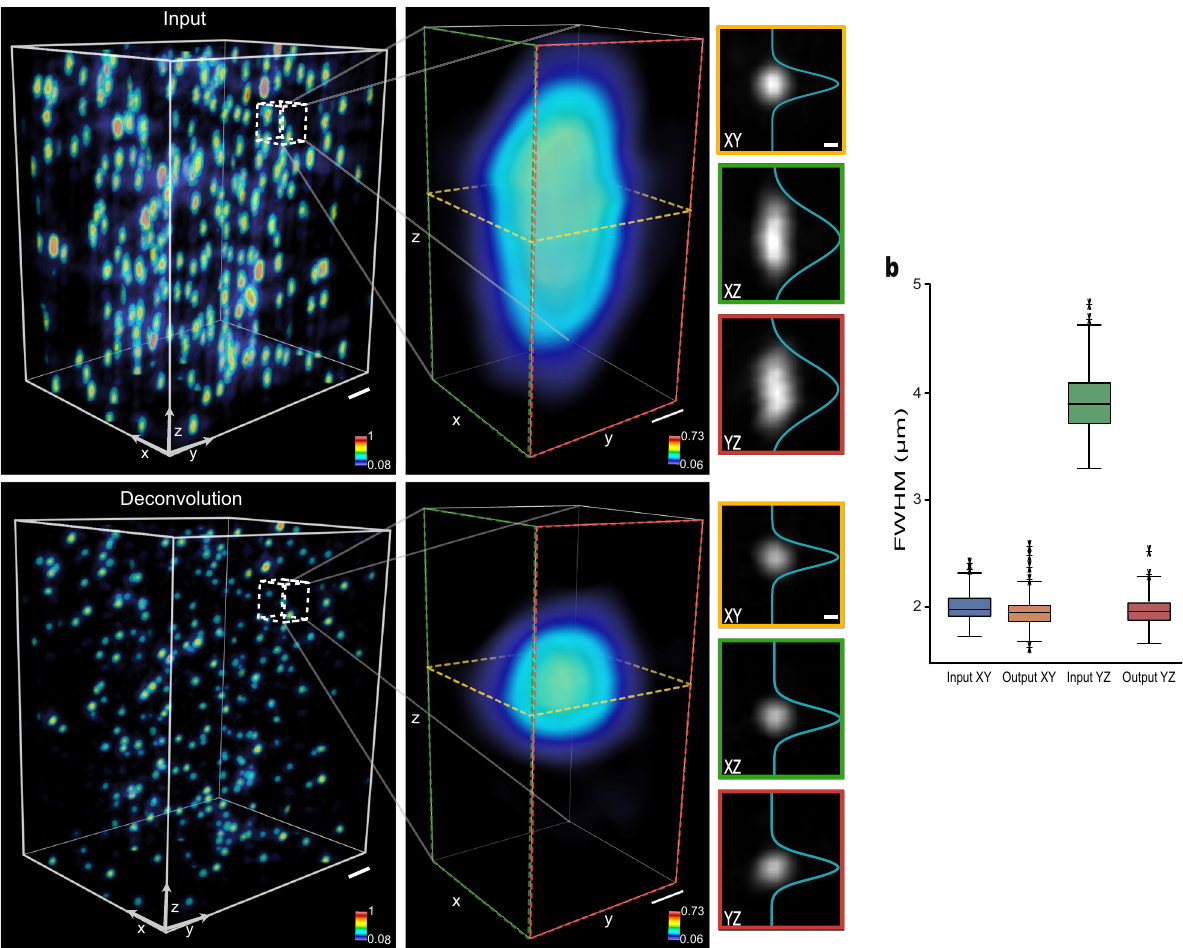
Fig. 3 PSF Deconvolution by the framework. The 0.5- µ m fl uorescent beads were imaged to model the PSF of the OT-LSM system experimentally. a An example of PSF deconvolution visualized in 3D and 2D. The intensity pro fi les were fi t into Gaussian functions. Axial elongation is a common issue in fl uorescence microscopy. Our framework resolves it to the originally spherical fl uorescent bead. Slice images were visualized on the signal range of the input image. The color bars represent the signal intensity normalized between 0 and 1. Scale bars: 10 µ m (left), 1 µ m (middle and right). b FWHMs of experimentally measured PSFs in the lateral and axial planes before and after PSF deconvolution. We extracted bright spots from the same locations before applying the method ( n = 300 spots for the XY plane and 305 spots for the YZ plane from non-overlapping distinct regions). Each spot was fi t into a 2D Gaussian function, where FWHM was calculated. The PSFs in the axial plane were deconvolved to the almost identical resolution as those in the lateral plane. For the box plot, the box shows the IQR between Q1 and Q3 of the dataset, with the central mark showing the median and the whiskers indicating the minimum (Q1-1.5*IQR) and the maximum (Q3 + 1.5*IQR). Outliers are represented by asterisk-shaped markers beyond the